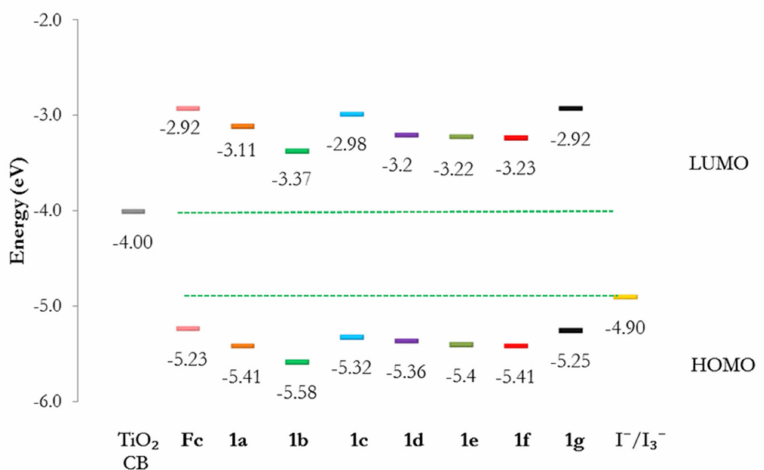
Figure 4. Scheme of the energy levels of the investigated Fc derivatives compared to the conduction band (CB) of TiO 2 and iodide / triiodide redox